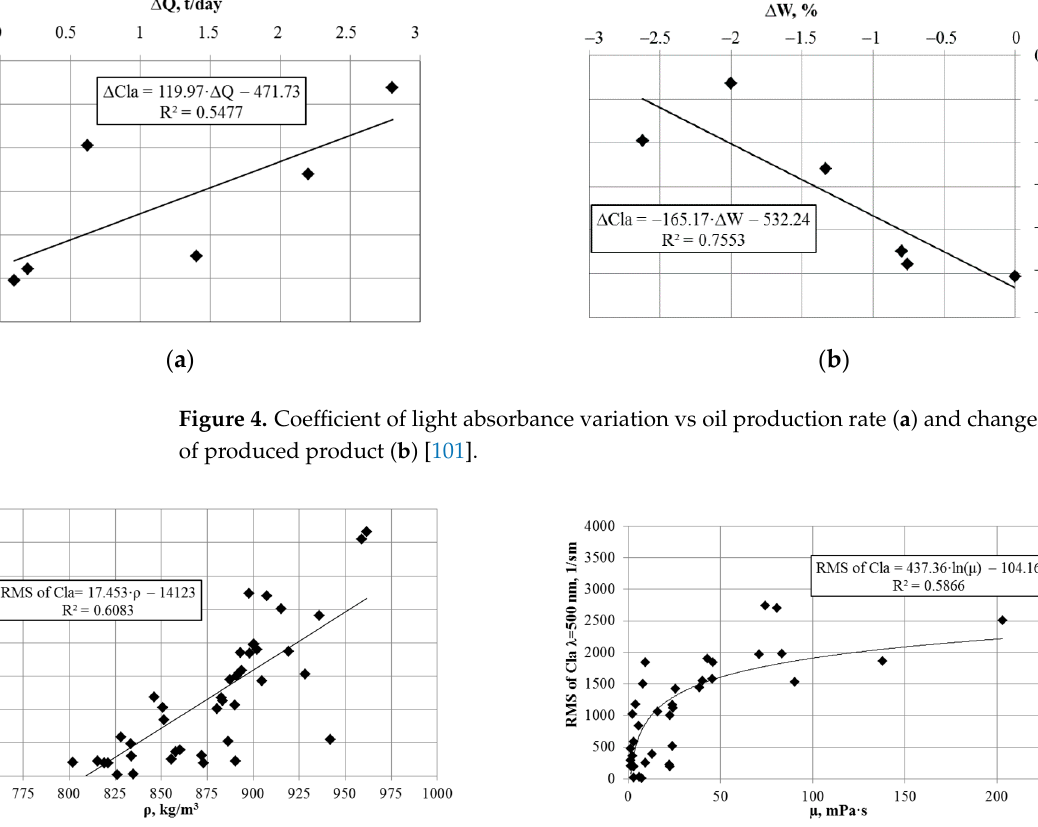
Figure 5. Relationship between RMS of Cla and density ( a ) and dynamic viscosity ( b ) [102].